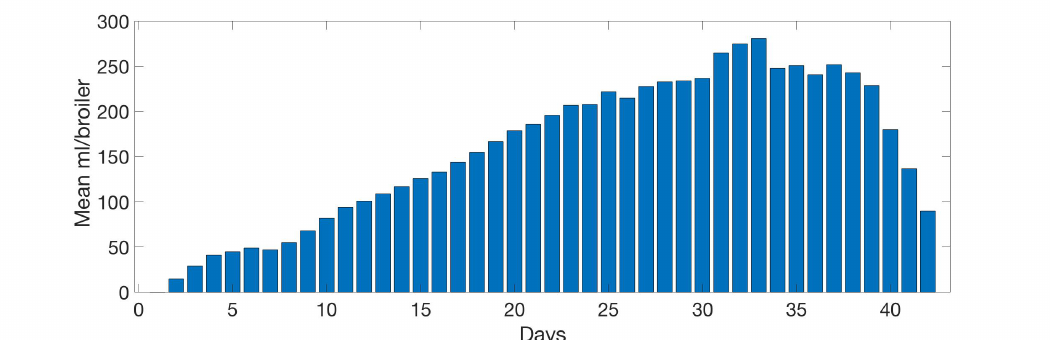
Figure 13. Evolution of the mean food intake per day by the birds. Data collected daily by the farm management.